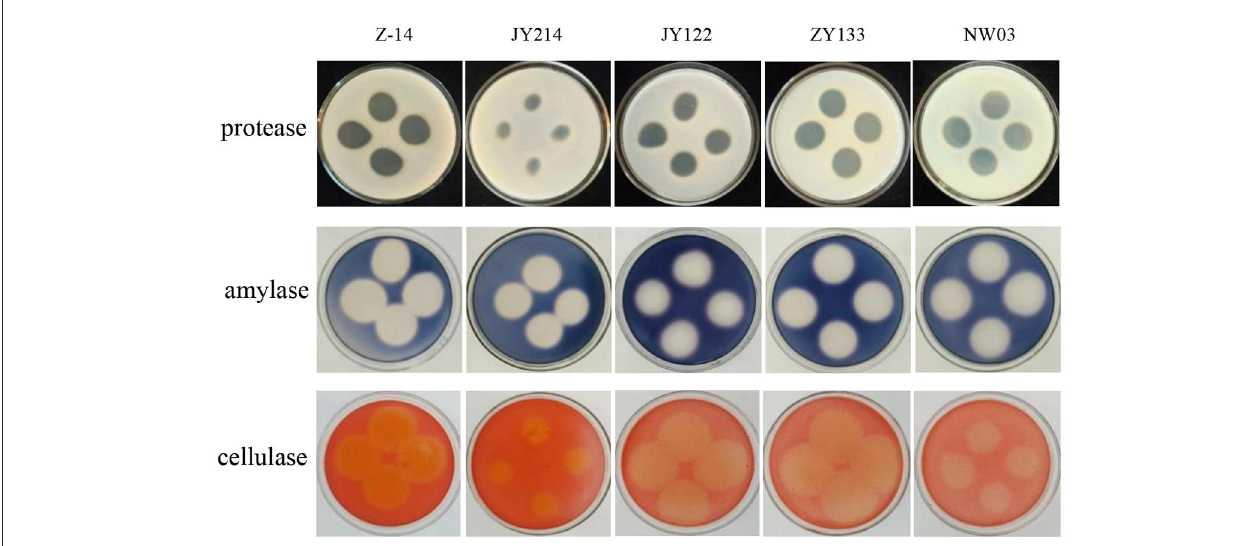
FIGURE4 Secondary metabolite detection. Medium containing milk, starch, and sodium carboxymethyl cellulose were used to detect protease, amylase, and cellulase activities, respectively. Secondary metabolites were dropped and cultured at 37 ◦ C for 48h.